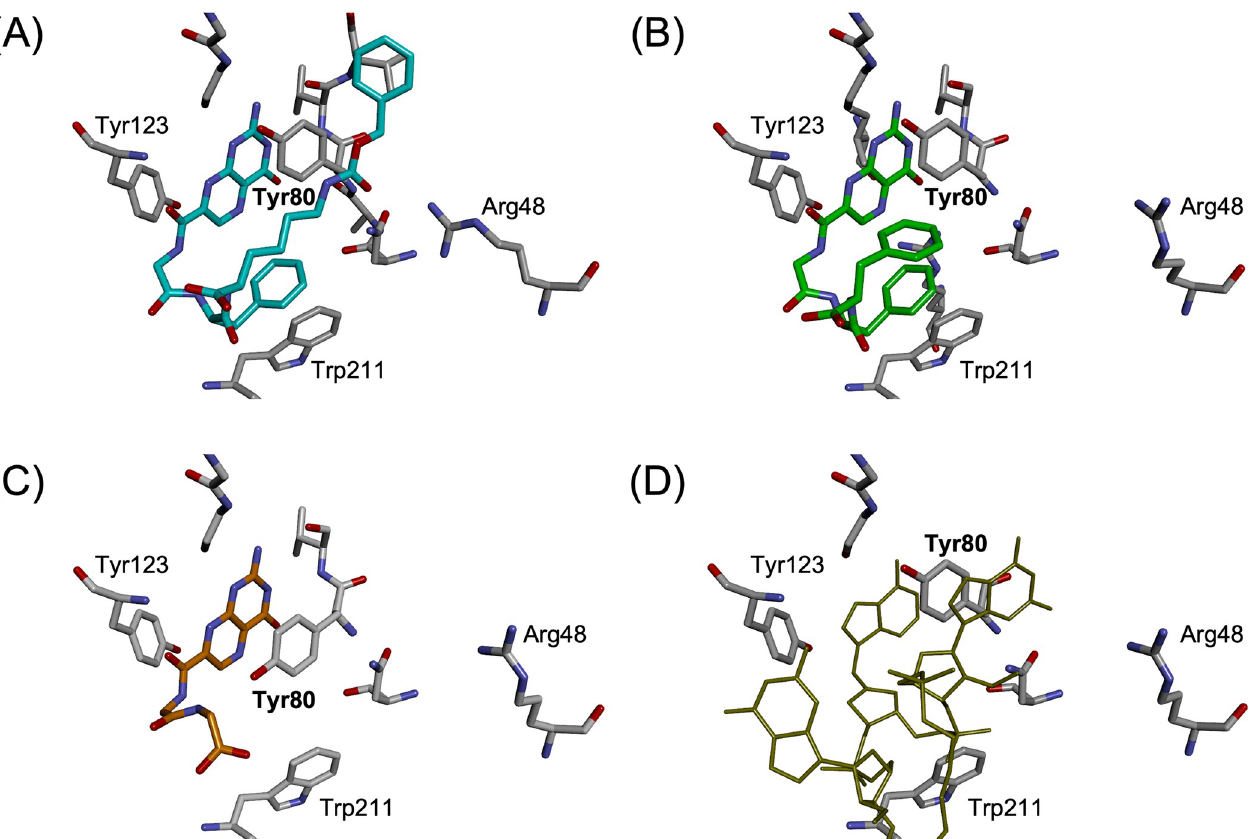
Fig 4. Comparison of the crystal structures of RTA-inhibitor complexes. (A) crystal structure of 4b -RTA complex, (B) crystal structure of 2 -RTA complex (PDB ID: 4HUP), (C) crystal structure of 3 -RTA complex (PDB ID: 4HV7), and (D) crystal structure of RTAS complexed with the cyclic transition-model inhibitor (PDB ID: 3HIO). Images are drawn by Discovery Studio Visualizer